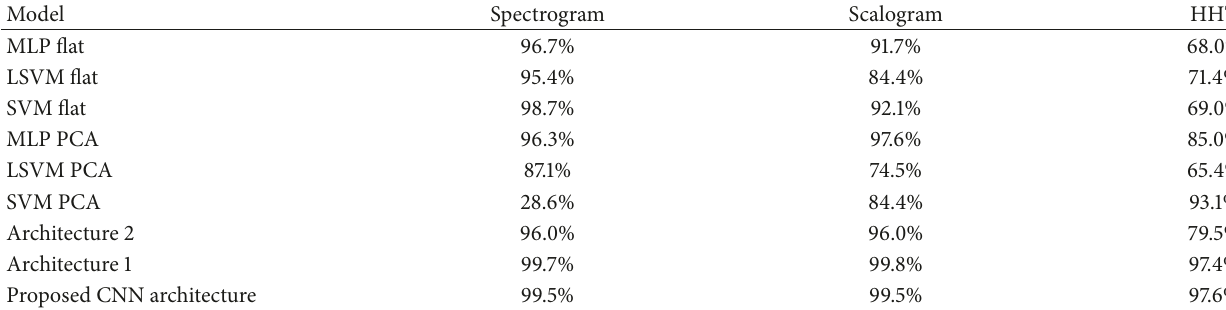
Table 19: Prediction accuracies for 96 × 96 image inputs.